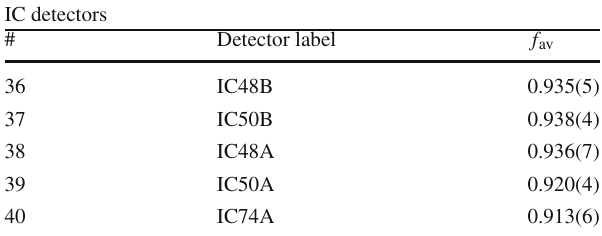
Table 4 Active volume fractions f av of IC detectors used in the final analysis of [26]. The f av values are pulled from a preliminary analysis